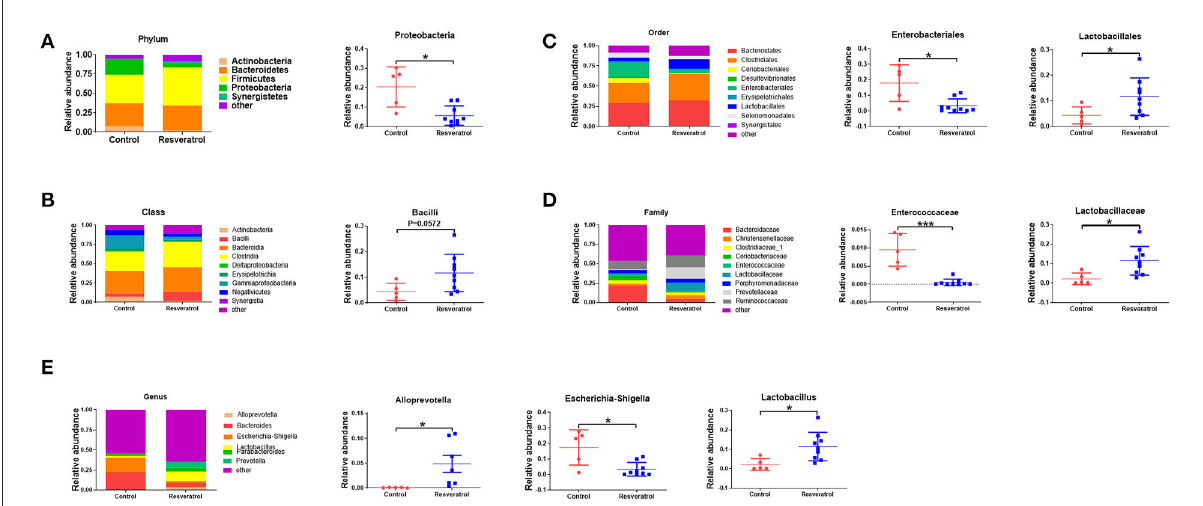
FIGURE6 (A–E) Relative abundances of main taxa at different levels. Values are means ± SEMs. Differences were assessed by unpaired t -test with Welch’s correction or Mann–Whitney U -test. The selection of analysis methods depends on whether the data were in Gaussian distribution and had equal variance or not. Values are means SEMs. Data were denoted as follows: * p < 0.05, *** p <